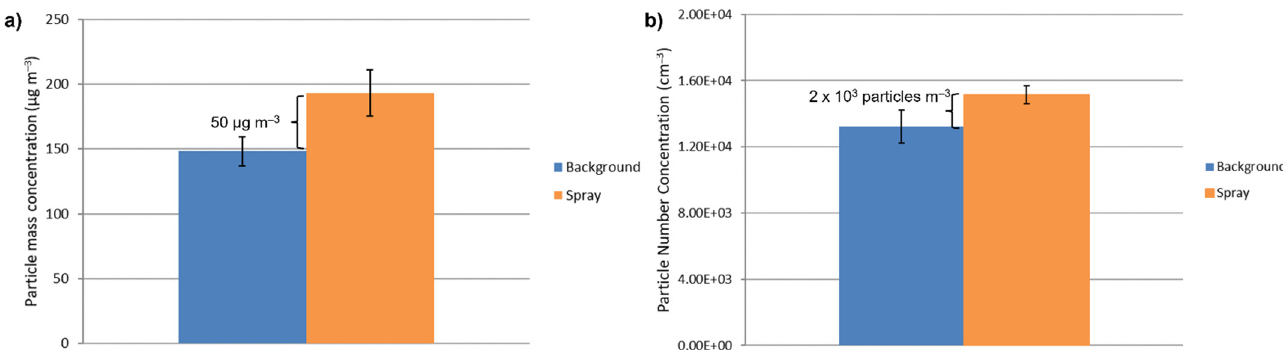
Figure 12. ( a ) Particle mass concentrations measured by means of the DustTrack and ( b ) particle number concentrations measured by means of the DiSCmini. Averages concentration before starting the coatings (Background) and at the end of the process (Spray). Bars show the variability of the concentration (one standard deviation).